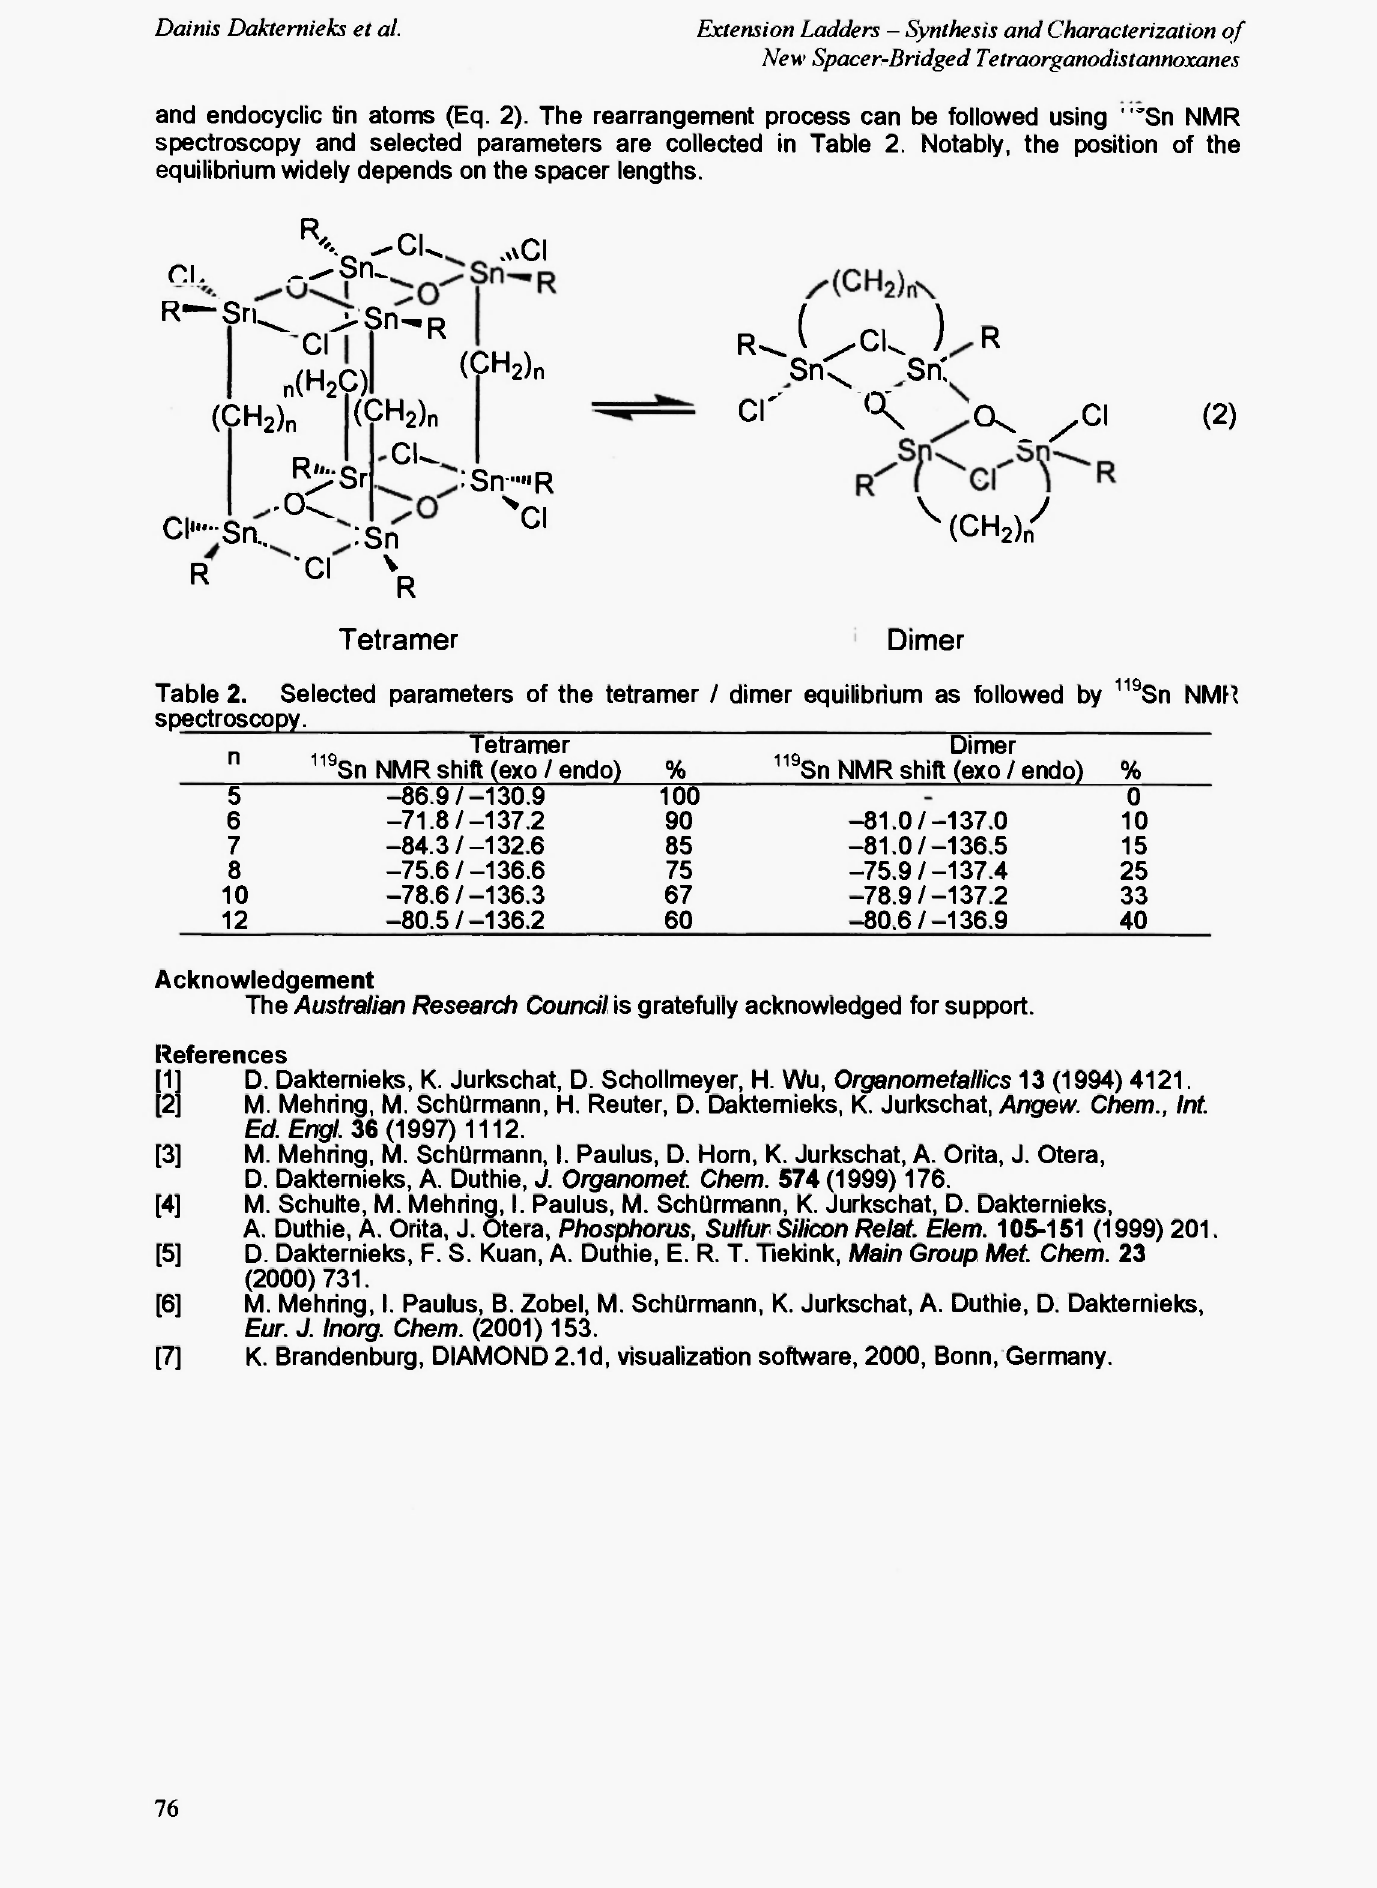
Selected parameters of the tetramer / dimer equilibrium as followed by spectroscopy.